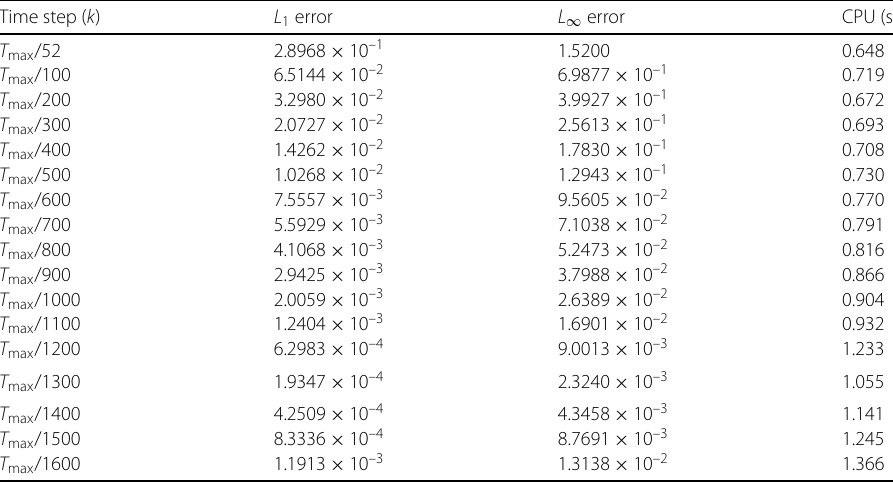
Table 2 L 1 and L ∞ errors and CPU time at some different values of time-step size k for Problem 1 with ρ = 10 4 at time 2.5 × 10 –3 with spatial mesh size h = 0.01 using FTCS scheme, where